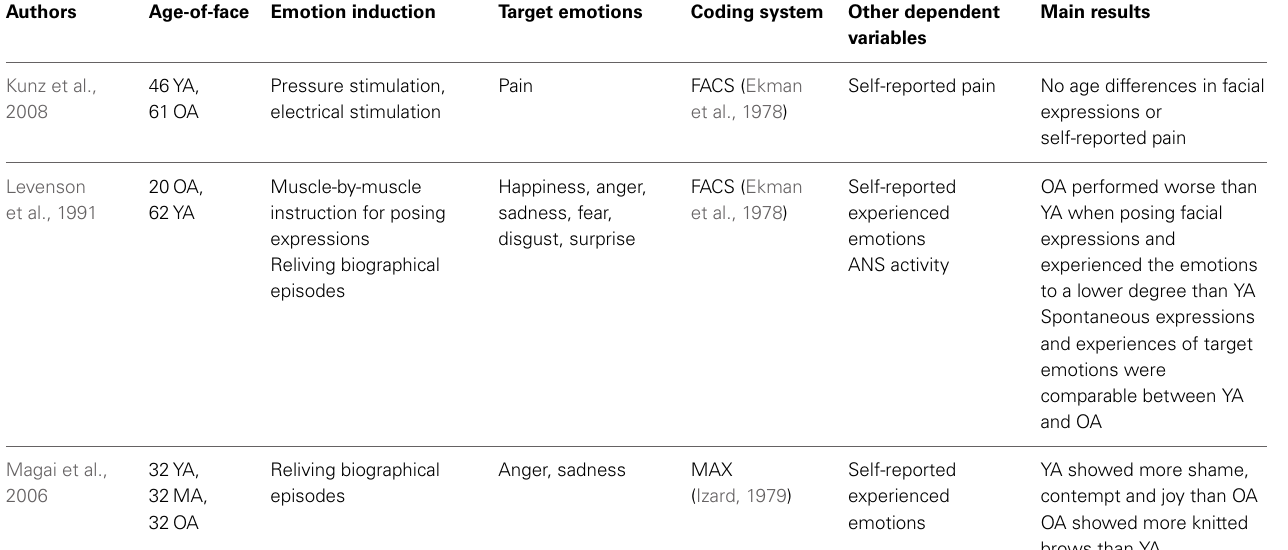
Table 2 | Summary of research on age differences in facial